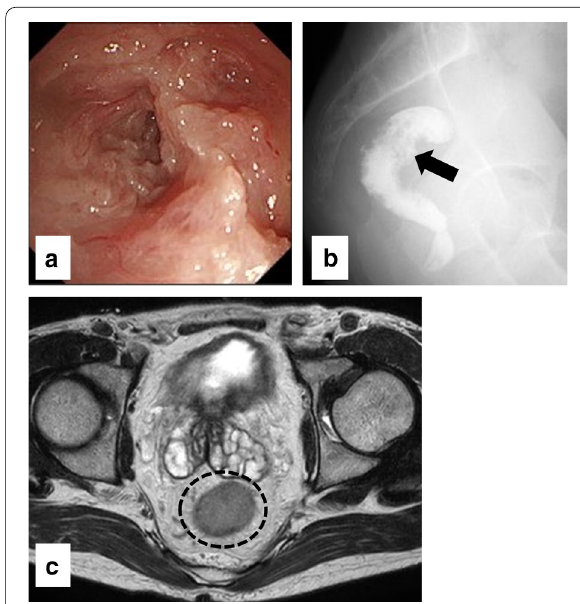
Fig. 1 Preoperative examination findings. a Colonoscopy showed a circumferential tumor in the residual rectum. b Contrast enema showed the tumor located at the low rectum (black arrow). c Magnetic resonance imaging revealed the circumferential tumor at the low rectum (dashed circle). The depth of wall invasion by the tumor was estimated as T2 because the muscle layer of the rectum was